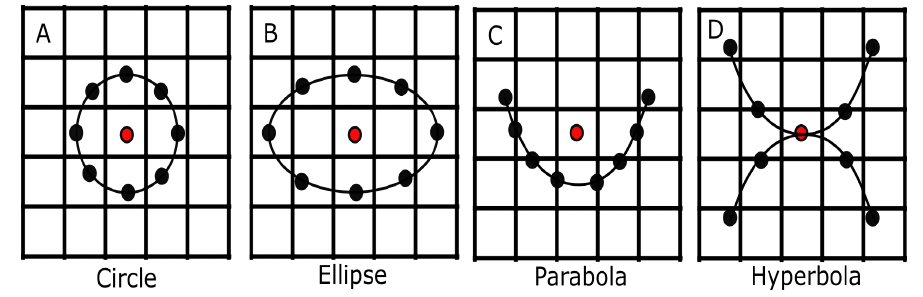
Figure 7. Five different neighbourhood topologies employed in our study. Table 1. Parameter descriptions for all neighbourhood topologies. Note that a and b are the semimajor and semiminor axis lengths, and c is the distance between vertex and focus.